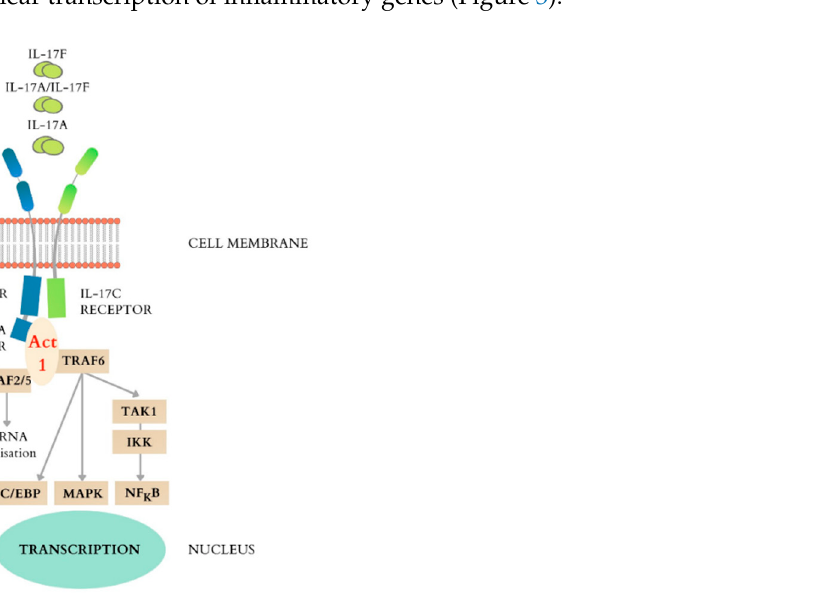
Figure 3. The IL-17 cytokines and their receptors, the main signaling events downstream of the ac- tivation of IL-17A receptor.